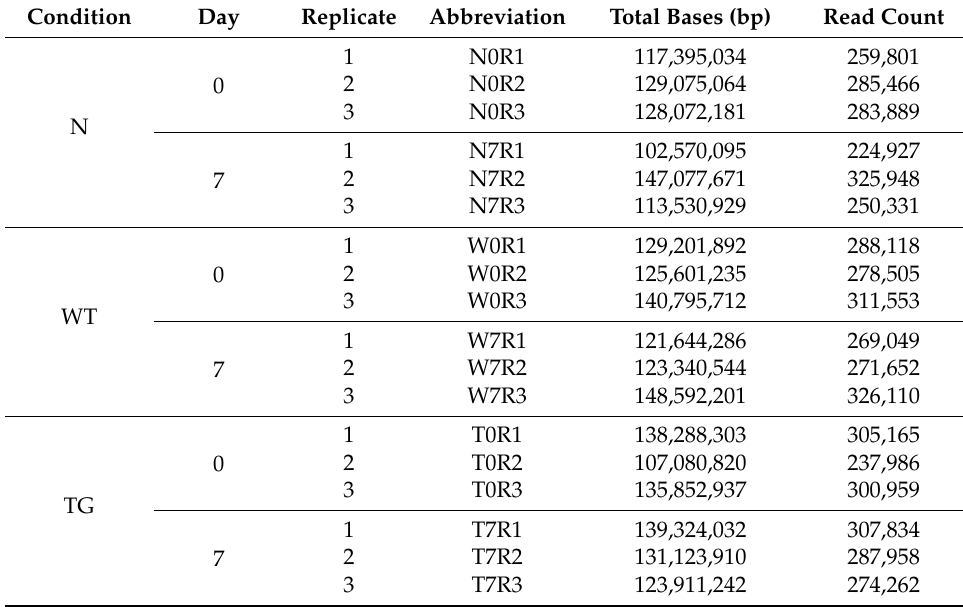
Table 1. Summary of treatment conditions and samples with respective sequencing